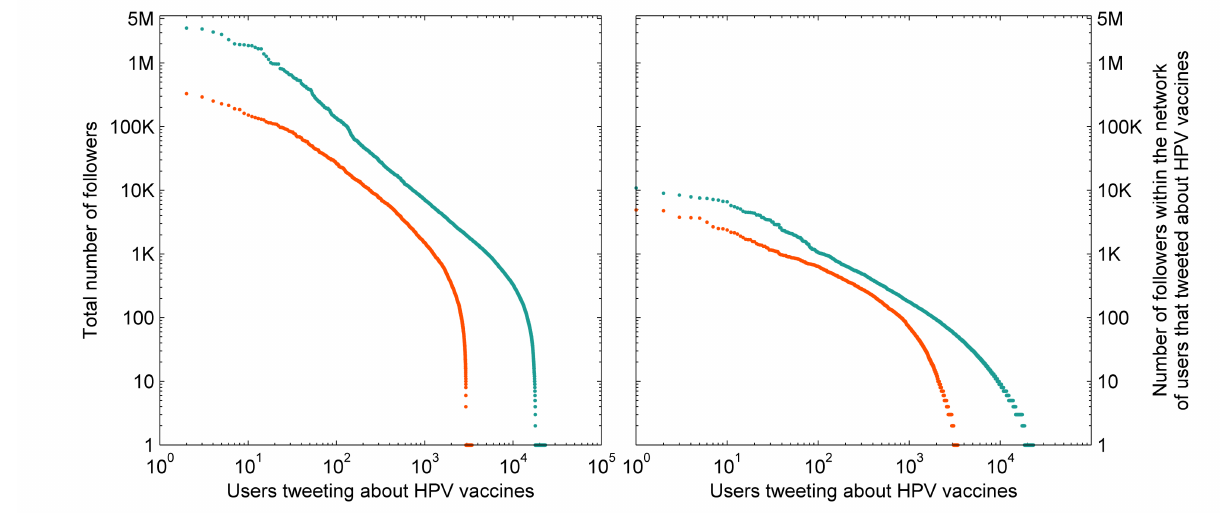
Figure 3. The ordered distribution of users according to the total follower counts (left) and follower counts within the network of 30,621 users (right). Each user is represented by a dot and colored by users that tweeted mostly negative tweets (orange) compared to all other users (cyan). The vertical axes are zero-adjusted to accommodate users that had zero followers.